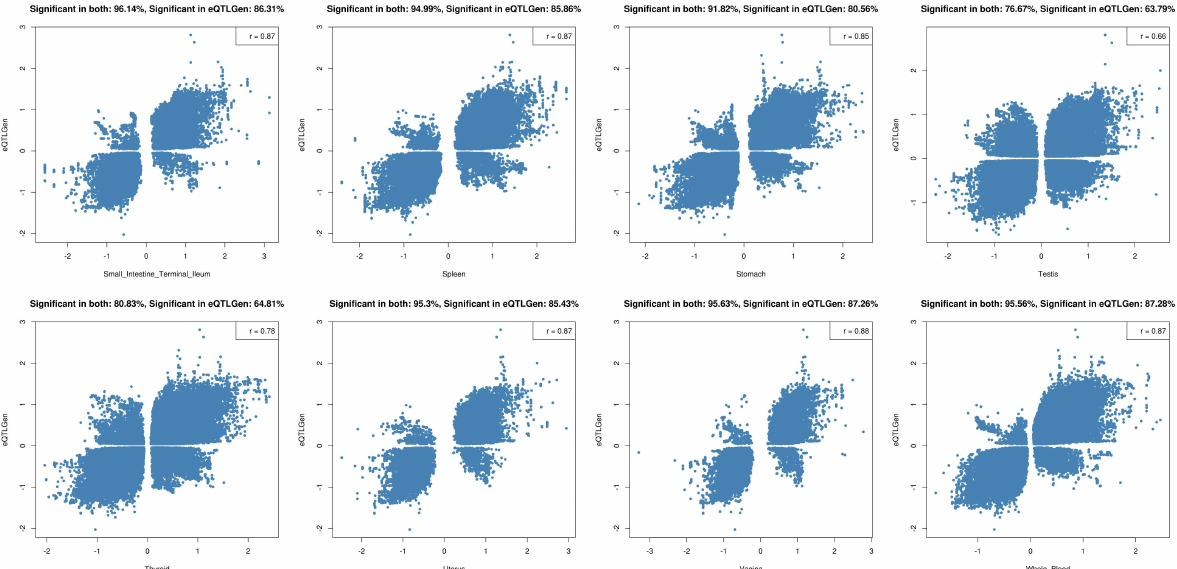
Figure A1. Correlation of effect estimates between eQTLGen dataset and significant (FDR < 0.05) eQTLs from 48 GTEx tissues. Two numbers are reported above each plot: ‘Significant in both’ indicates the percentage of genome-wide significant (GW-sig) eQTLs in each tissue that are also GW-sig in eQTLGen; ‘Significant in eQTLGen’ indicates the percentage of FDR-significant eQTLs of each tissue that that reach GW-sig only in eQTLGen. Palindromic SNPs were removed prior to